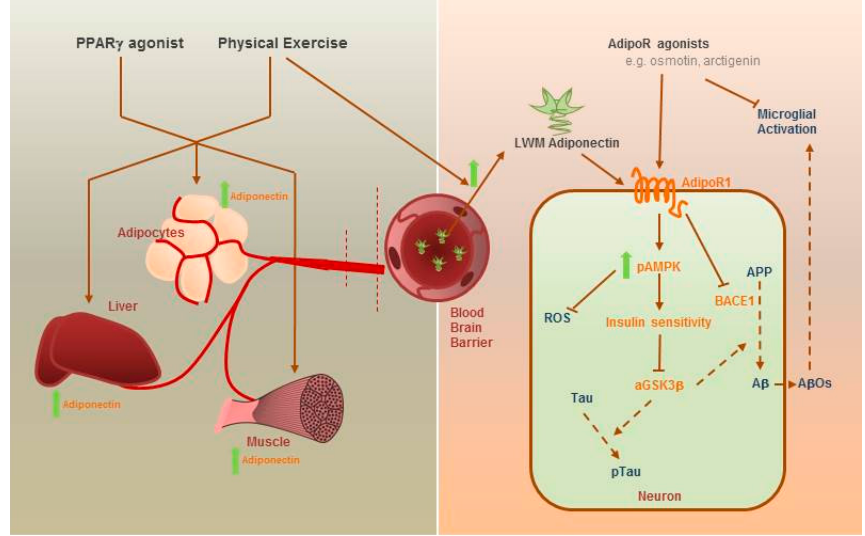
Figure 2. Strategies to increase adiponectin signaling in AD neurons. Peripherally, adiponectin expression from the liver, adipocytes and muscle can be increased by administering PPAR γ agonist (e.g., pioglitazone) and physical exercise induction. Physical exercise can also increase the transport of low molecular weight nd trimeric adiponectin across the blood-brain barrier (BBB). Administration of adipoR agonists and LMW adiponectin acts on AdipoR1 in neurons and microglia to exert neuroprotection. Green arrow denotes increase, arrows and dash arrows denote promotion, T-bars denote inhibition.